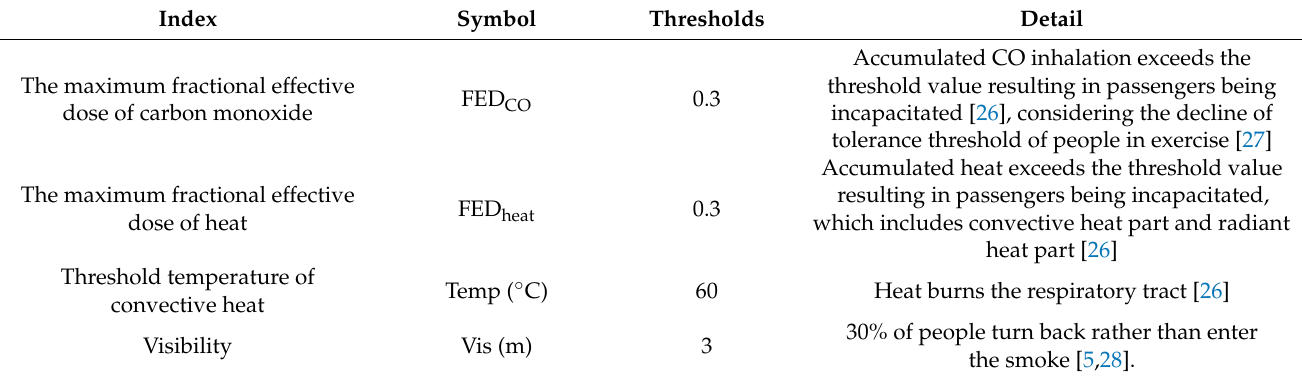
Table 3. Calculation index of available safe escape time (ASET).